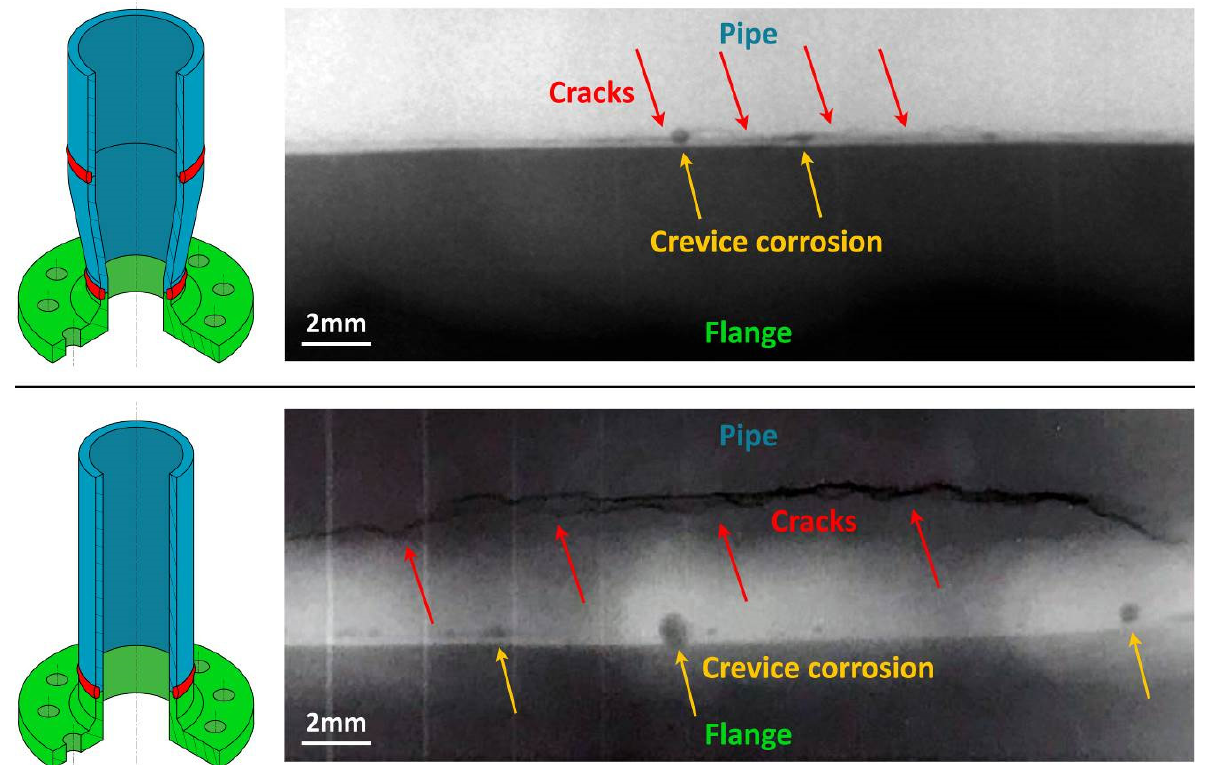
Figure 4. X-ray analysis. Welds are characterized by lack of fusion that generated crevice corrosion between the pipe and flange edges (orange arrows). Branched cracks are visible in welded area and heat-affected zone (red arrows).